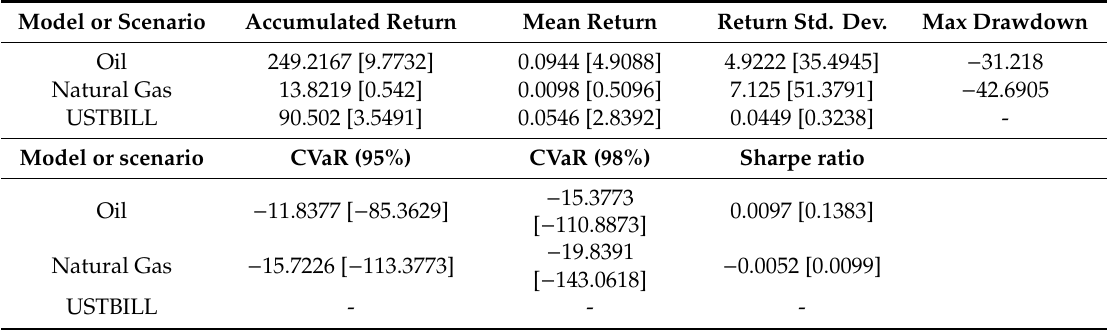
Table 4. Performance of a passive or “buy-and-hold” investment strategy in the two simulated energy commodities and the U.S. Treasury